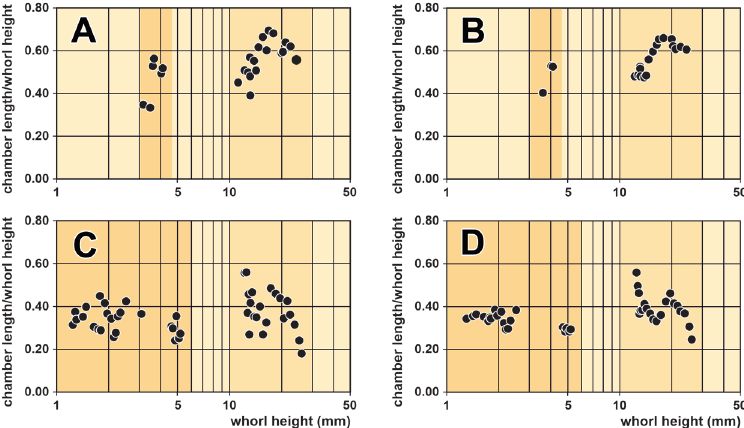
Fig. 35. Septum distances in Lituites lituus de Montfort, 1808 from the Upper Grey Orthoceratite Limestone. A, C = empirical data points; B, D = three data points averaged. A–B . Specimen MB.C.2497 (Helms 1966 Coll.) from Groß Zicker (Island of Rügen, Mecklenburg-Vorpommern). C–D . Specimen MB.C.11990 (Helms 1966 Coll.) from Groß Zicker (Island of Rügen,